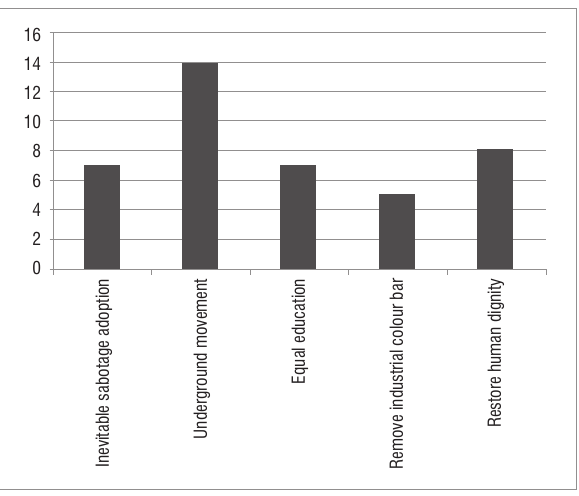
Figure 3: Number of occurrences of themes supporting resilience.